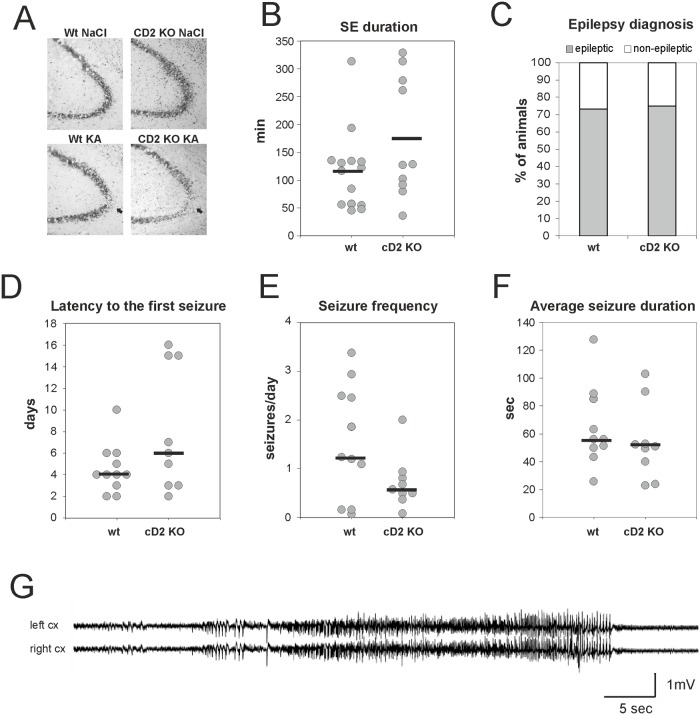
Epileptogenesis in wt and cD2 KO mice following intra-amygdala kainic acid injection.
(A) Neurodegeneration in CA3 of the hippocampus at 8 d after KA-induced status epilepticus. (B) Duration of status epilepticus, (C) percent of animals developing epilepsy, (D) latency to the first spontaneous seizure, (E) seizure frequency in epileptic mice and (F) average spontaneous seizure duration in wt and cD2 KO mice following intra-amygdala kainic acid injection. (G) An example of an electrographic seizure detected in a cD2 KO animal. Arrows in A indicate the area of neuronal loss. Each circle in B and D-F represents one animal, and horizontal bars indicate mean (B) or median (D-F) values; cx—cortex, KO—knock-out, SE—status epilepticus, wt—wild type.